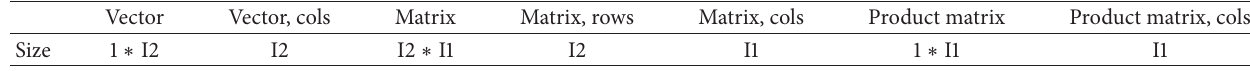
Table 4: Matrix size determination for vector-matrix multiplication.